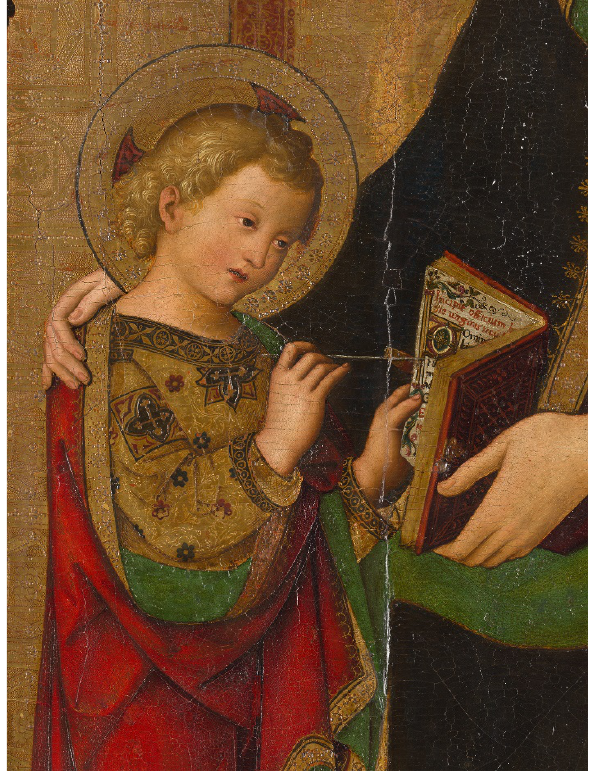
Figure 11 . The Christ Child learning to read.